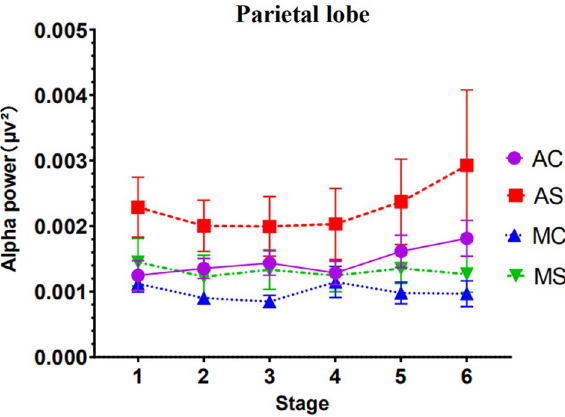
Figure 10. EEG parietal region alpha wave power (Note: Vertical bars represent standard errors, * p < 0.05).